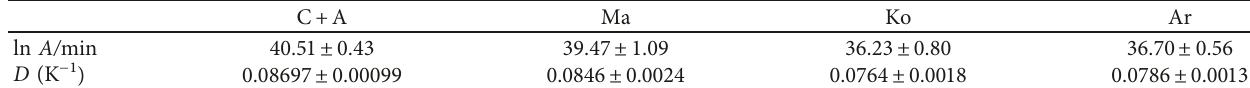
Table 4: Values of the kinetic parameters with their standard errors.